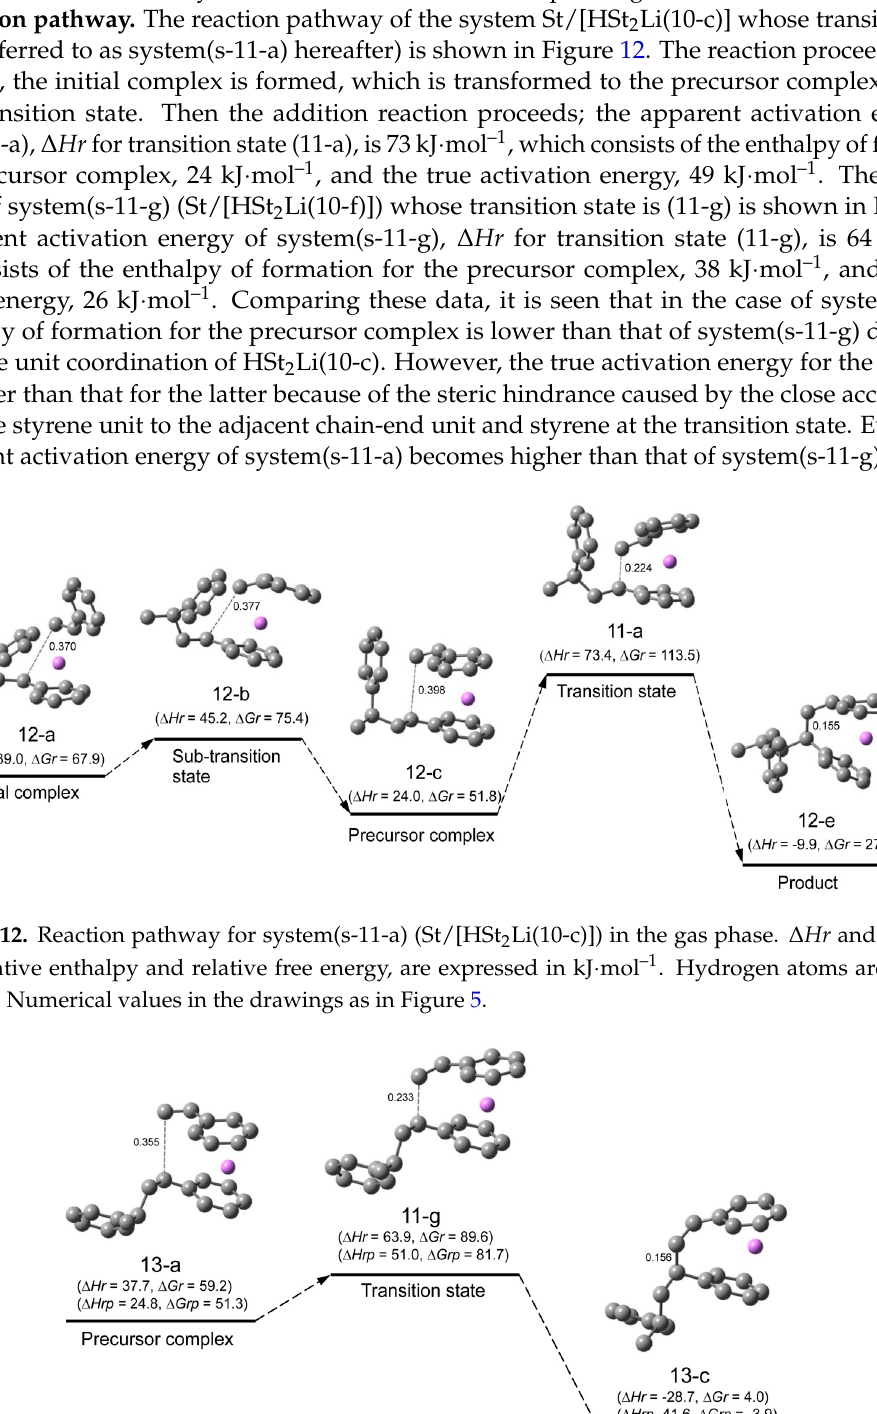
Figure 13. Reaction pathway for system(s-11-g) (St/[HSt 2 Li(10-f)]) in the gas phase. ∆ Hr and ∆ Gr , the relative enthalpy and relative free energy, are expressed in kJ·mol –1 . ∆ Hrp and ∆ Grp in the lower parentheses are the enthalpy and free energy with respect to (St + 1/2[(HSt 2 Li) 2 (9-f)]), in kJ·mol –1 . The other drawing details as in Figure 12.